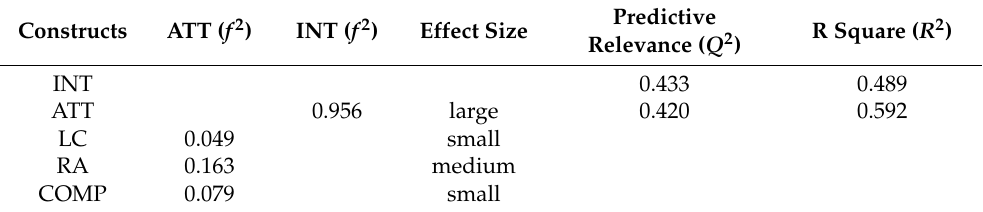
Table 15. Summary of Effect Size ( f 2 ), Predictive Relevance ( Q 2 ), and Coefficient of Determina- tion ( R 2 ).